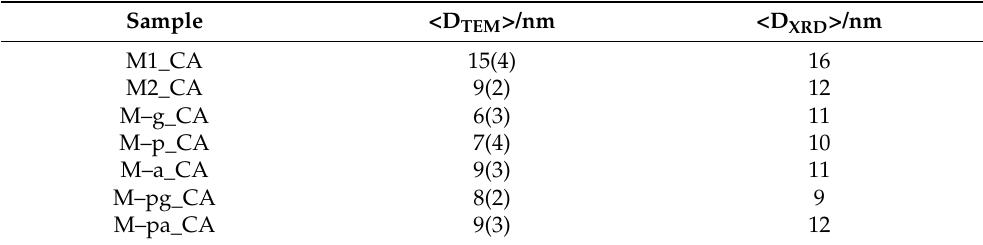
Figure 10. Typical TEM images of the grid-dried water dispersions for ( a ) M − p_MQ and ( b ) M − pa_MQ. Table 8. Mean particle sizes (<D TEM >) with associated standard deviations from Log-Normal distributions fitted to histograms of ~350 NPs (TEM images). <D XRD >: mean particle size determined from XRD data.